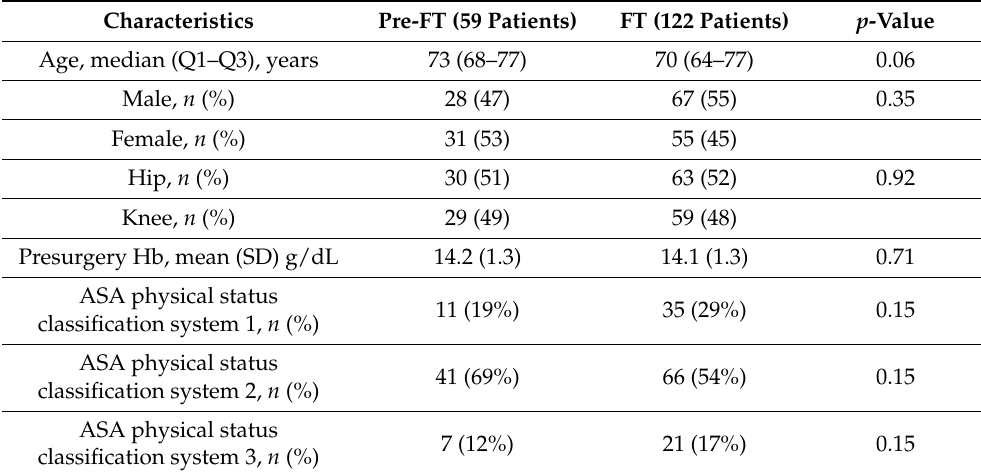
Table 2. Baseline characteristics of the patients after the propensity score matching.